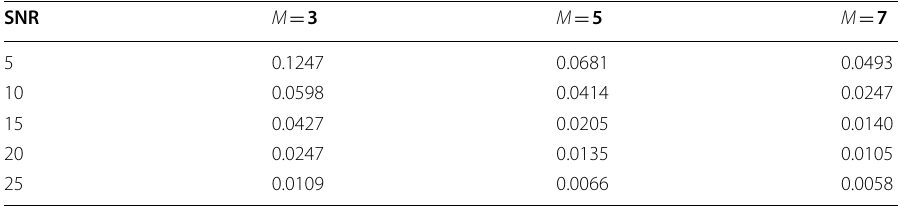
Table 6 RMSE values under different transmitting array elements M and